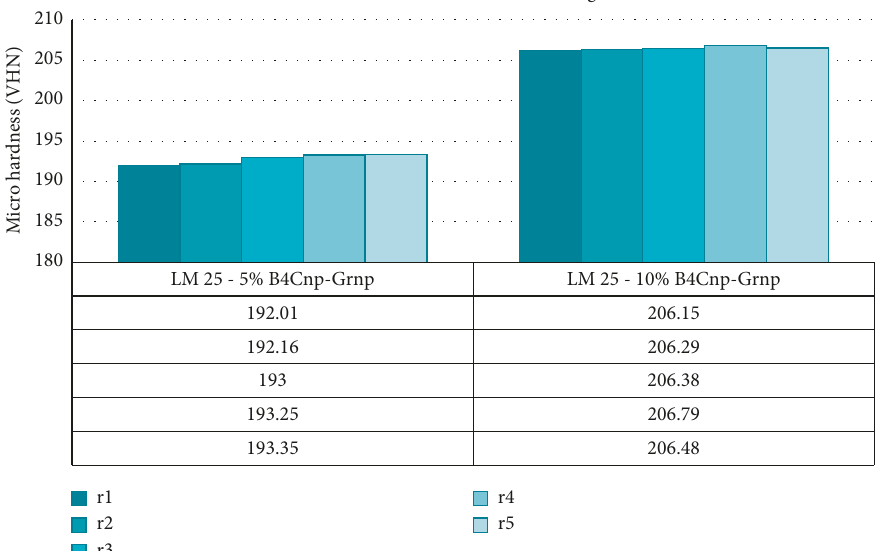
Figure 6: Microhardness values of LM 25-B4Cnp-Grnp hybrid composites. Table 2: Research studies on LM 25- B4Cnp-Grnp hybrid